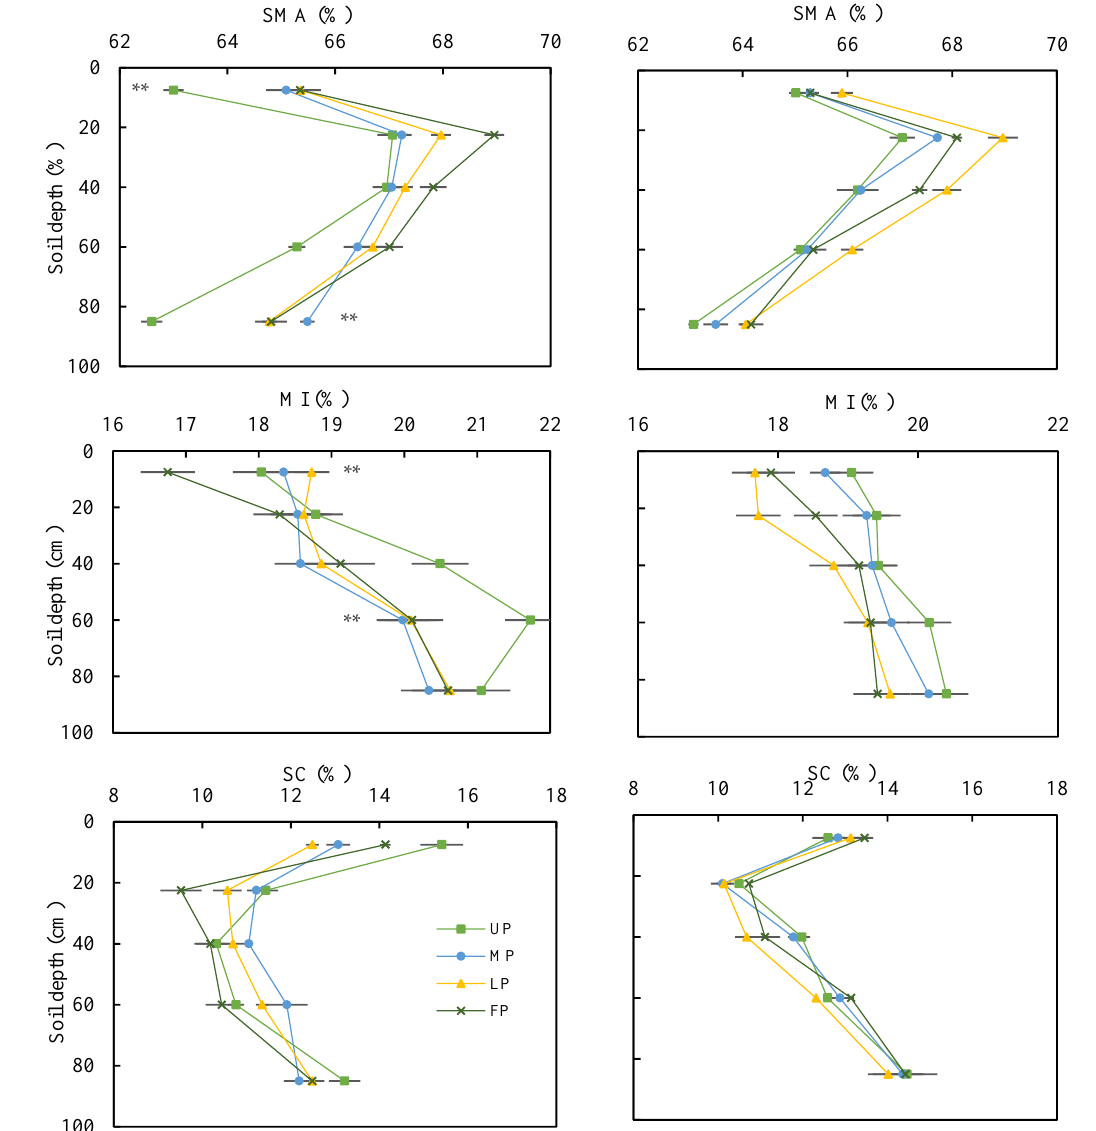
Figure 3. Profile distribution of water-stable aggregates at upper slope (UP), middle slope (MP), lower slope (LP), and footslope positions (FP) in sustainable cropland (left) and in conventional cropland (right). LMA: large macroaggregate (>2 mm); SMA: small macroaggregate (0.25 – 2 mm); MI: microaggregate (0.053 – 2 mm); SC: silt + clay fraction (<0.053 mm). The error bars are two standard errors of the means. ** indicates that the difference among different slope positions is significant at p < 0.05.